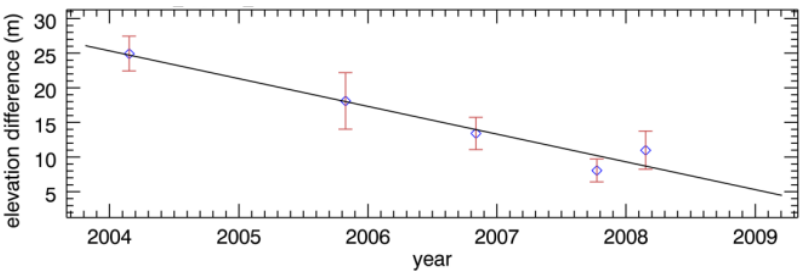
Figure 7. Linear trend of the surface lowering in area A3 fitted through multi-seasonal ICESat data using the Airphoto DEM as elevation reference. A terrain slope threshold of 10° and snow pack corrections were